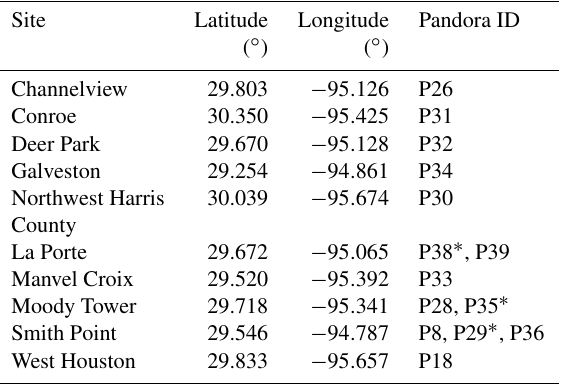
Table 2. DISCOVER-AQ sites with Pandora spectrometers over- flown by GCAS. The Pandora ID is a identification number given to each individual Pandora instrument. Asterisks indicate Pandoras used for MAX-DOAS measurements; all other Pandoras were used solely for direct-sun (DS) measurements. The mean GCAS over- pass time of Pandora sites is 10:07LT (earliest: 08:18LT; latest: 11:51LT) for morning flights and 15:25LT (earliest: 12:51LT;